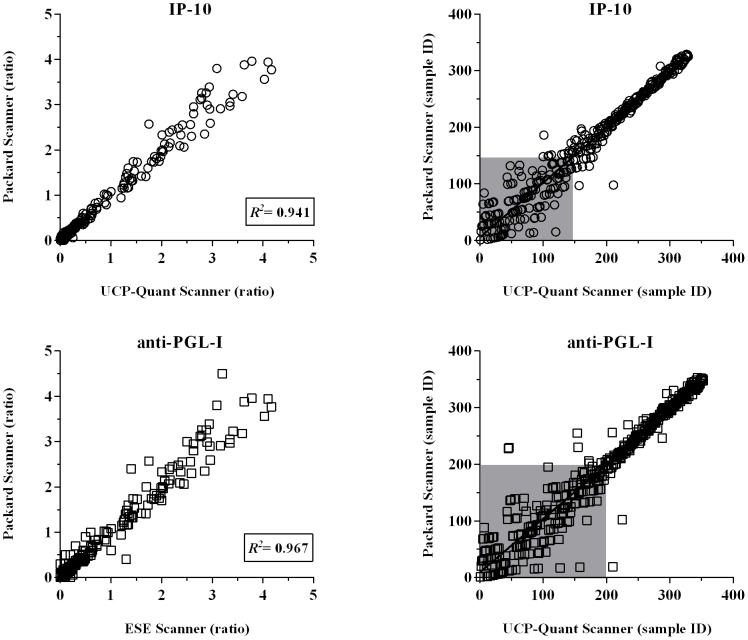
Performance of the portable lightweight UCP-Quant LF strip reader.Dry-format UCP-LFAs were performed for single detection of IP-10 and anti-PGL-I antibodies in an Ethiopian field setting (Figure 3). LF strips were analyzed using a portable reader (UCP-Quant). Subsequently, LF strips were shipped to The Netherlands and re-analysed using a dedicated lab-based FluoroCount microtiterplate reader (Packard) adapted for reading UCP-LF strips. Left panel: results are indicated as the ratio of the relative fluorescence units (RFUs) measured at Test and Flow-Control lines. R2 equals the square the Pearson correlation coefficient. Right panel: Spearman ranking. The grey box indicates samples scoring values below the specificity threshold.